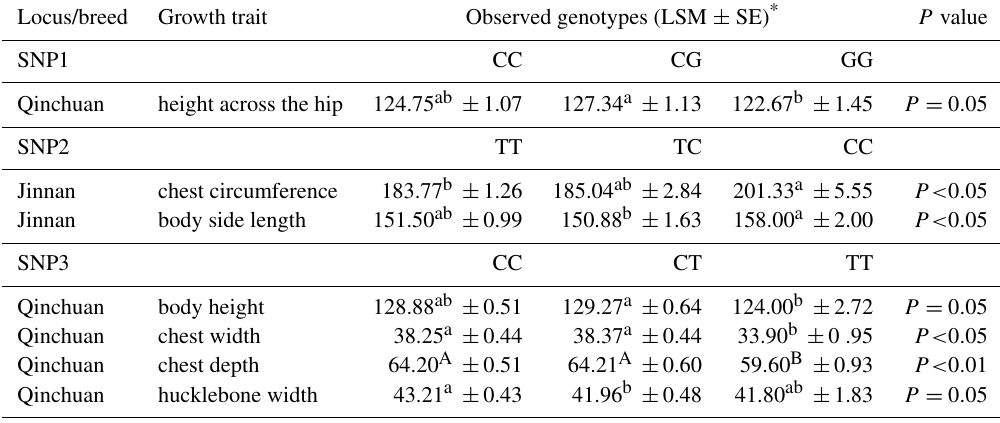
Table 5. Association of ATBF1 gene SNP3 genotypes and cattle growth traits. Locus/breed